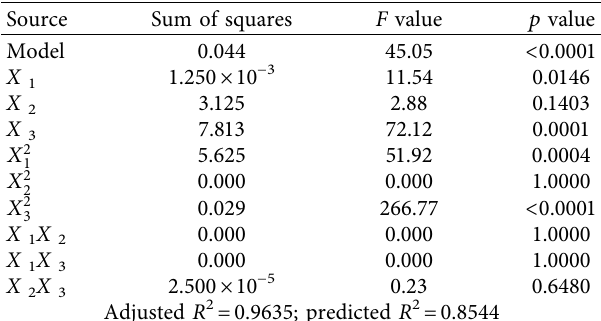
Table 8: Analysis of variance for regression models of softening